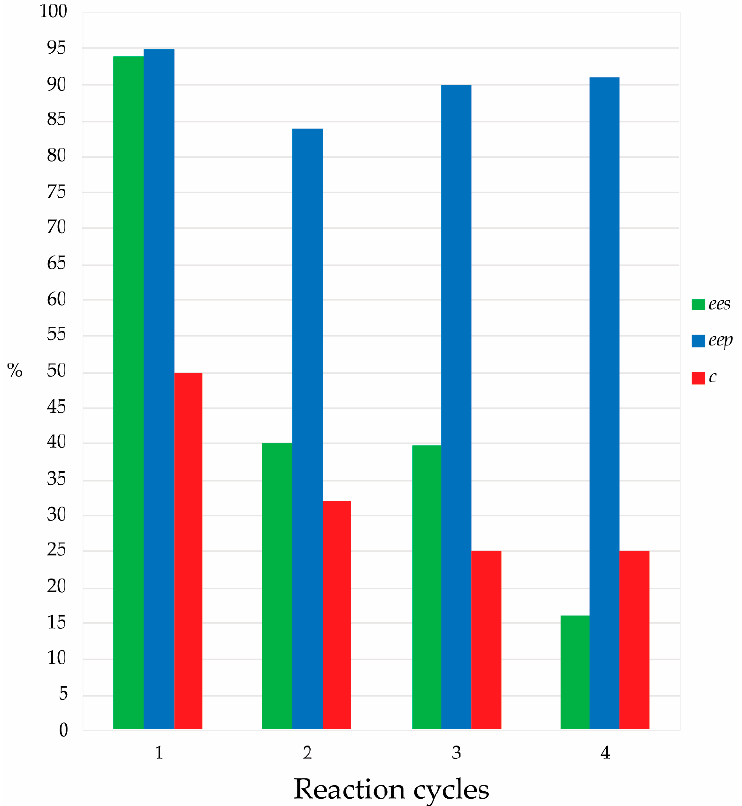
Figure 1. Results from the reuse of TLL immobilized on Immobead 150. Conditions: vinyl acetate as acyl donor, toluene as solvent, 30 °C, 15 min, 250 rpm and TLL: rac - 4a ratio of 0.5:1.